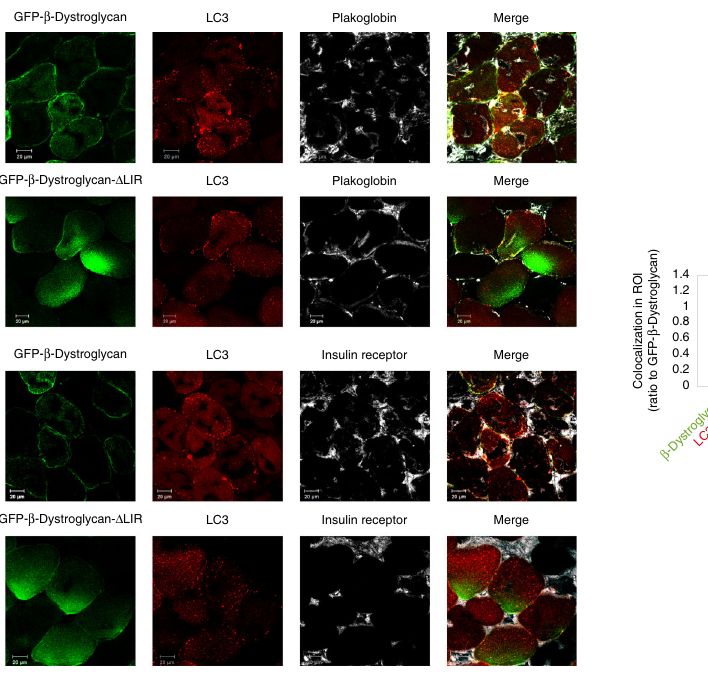
Proposed model for insulin receptor-DGC association via plakoglobin